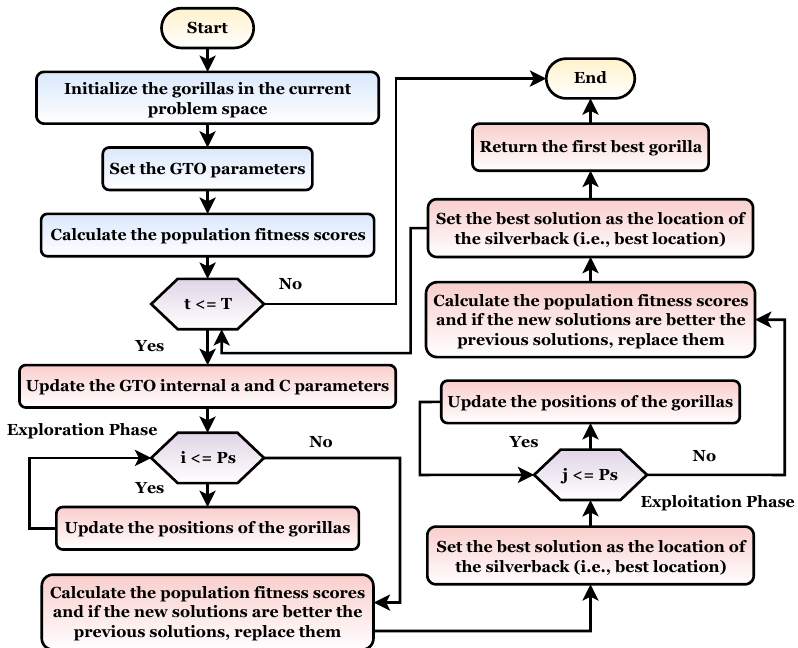
Figure 4. The gorilla natural behaviors